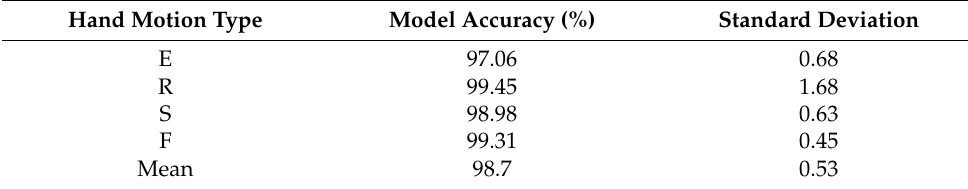
Table 4. The average accuracy after optimization by the state exclusion algorithm.